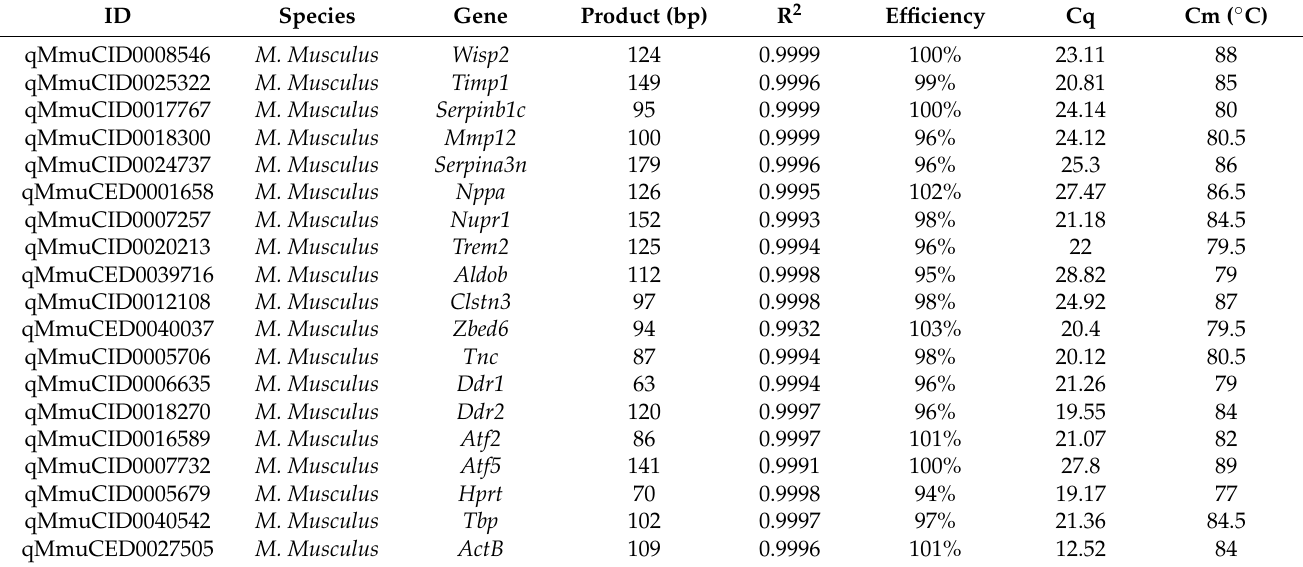
Table 1. List of the primers and their detailed specification used in the mouse gene expression